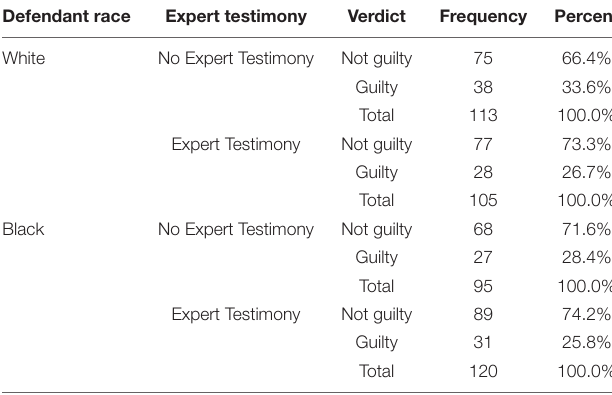
TABLE 2 | Second-degree murder verdicts by defendant race and expert testimony.